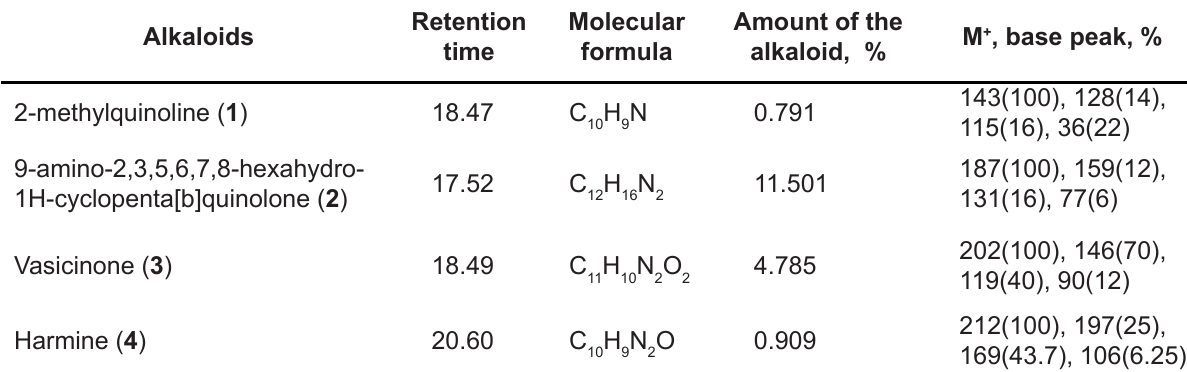
Table 1. Alkaloids from aerial parts of P.multisectum (Maxim) Bobrov determined by GC-MS analysis